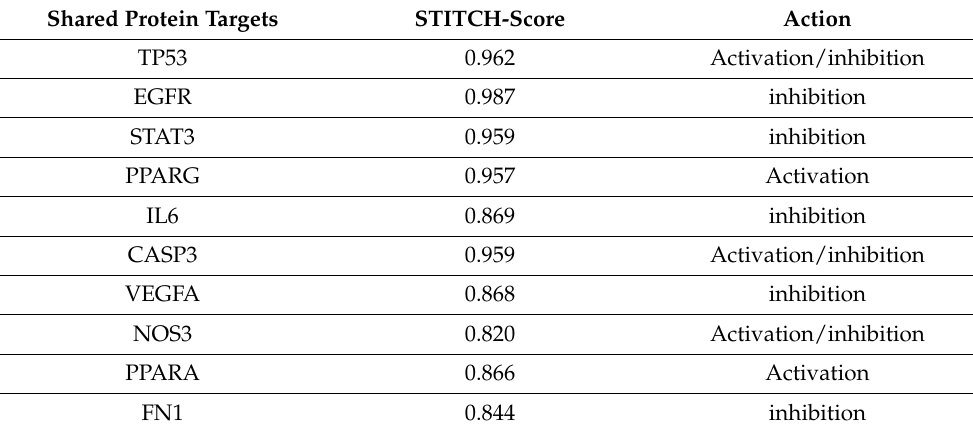
Figure 4. Intersection analysis to determine shared proteins between curcumin and curated genes related to diabetes using the Venn diagram: ( A ) All genes and ( B ) Hub genes. Table 2. The hub genes of the diabetes PPI network that are the targets of curcumin.